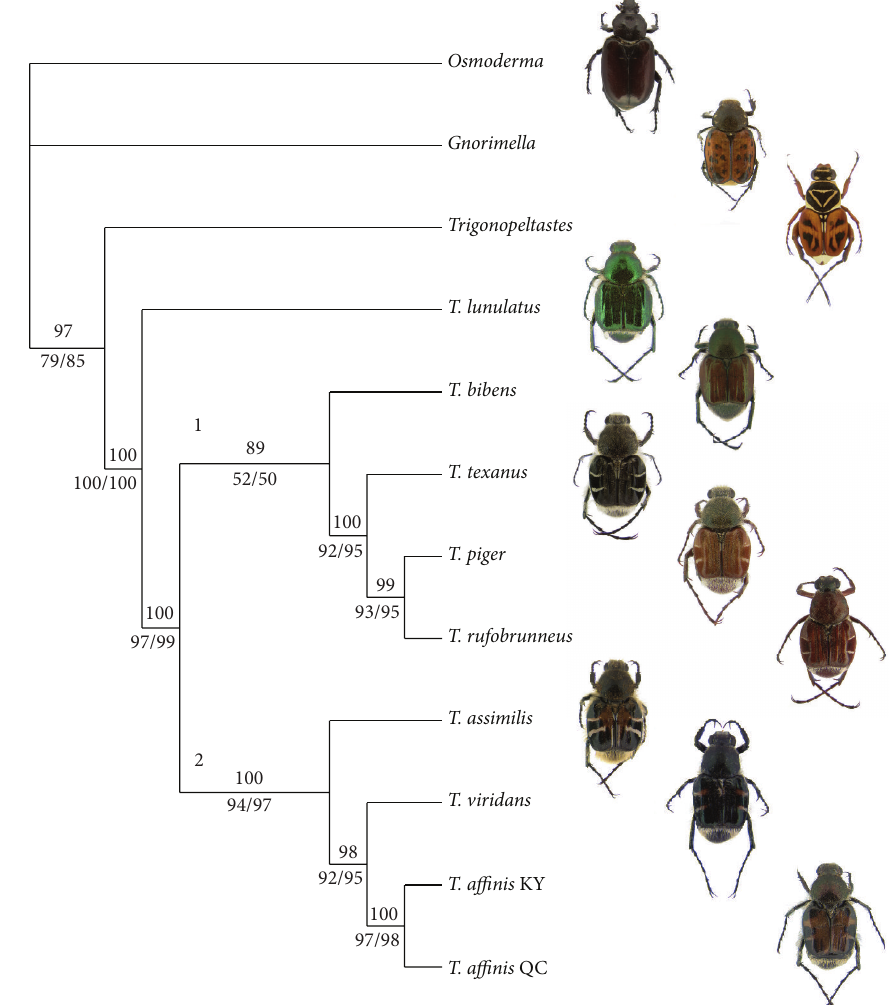
Figure 2: Topology of Trichiotinus found using both parsimony and Bayesian analyses and with all three data sets combined (CO1, 28S, and morphology) as well as a parsimony analysis using just the CO1 data. This is considered the best supported topology for the genus. Clade support values from the Bayesian analysis (above) and bootstrap/jackknife values (below) from the parsimony analysis are shown adjacent to each node, respectively. The two major clades discussed are labeled as 1 and 2 and the two included T. affinis sampled from Kentucky and Quebec are